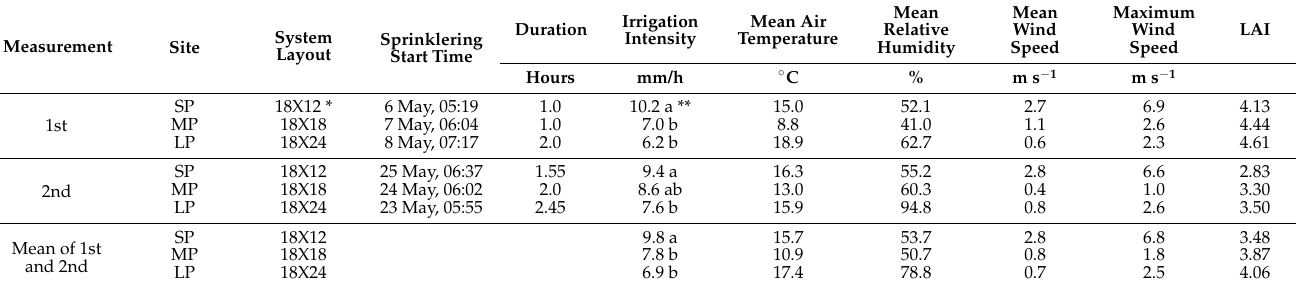
Table 1. Experimental date and corresponding climatic conditions in each